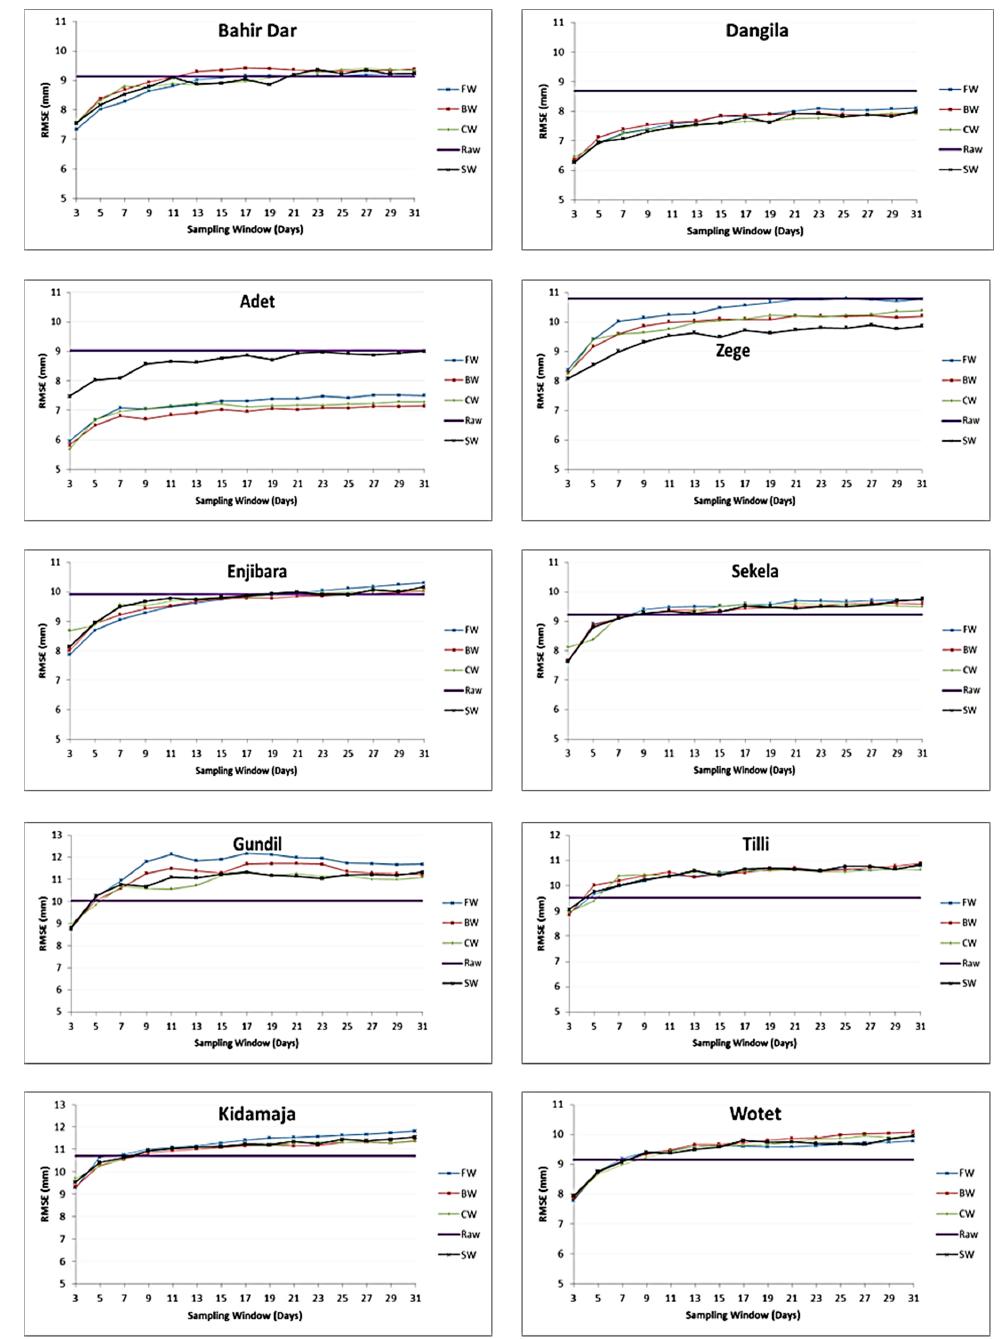
Figure 4. Results of FW, BW and CW schemes by the moving window approach.